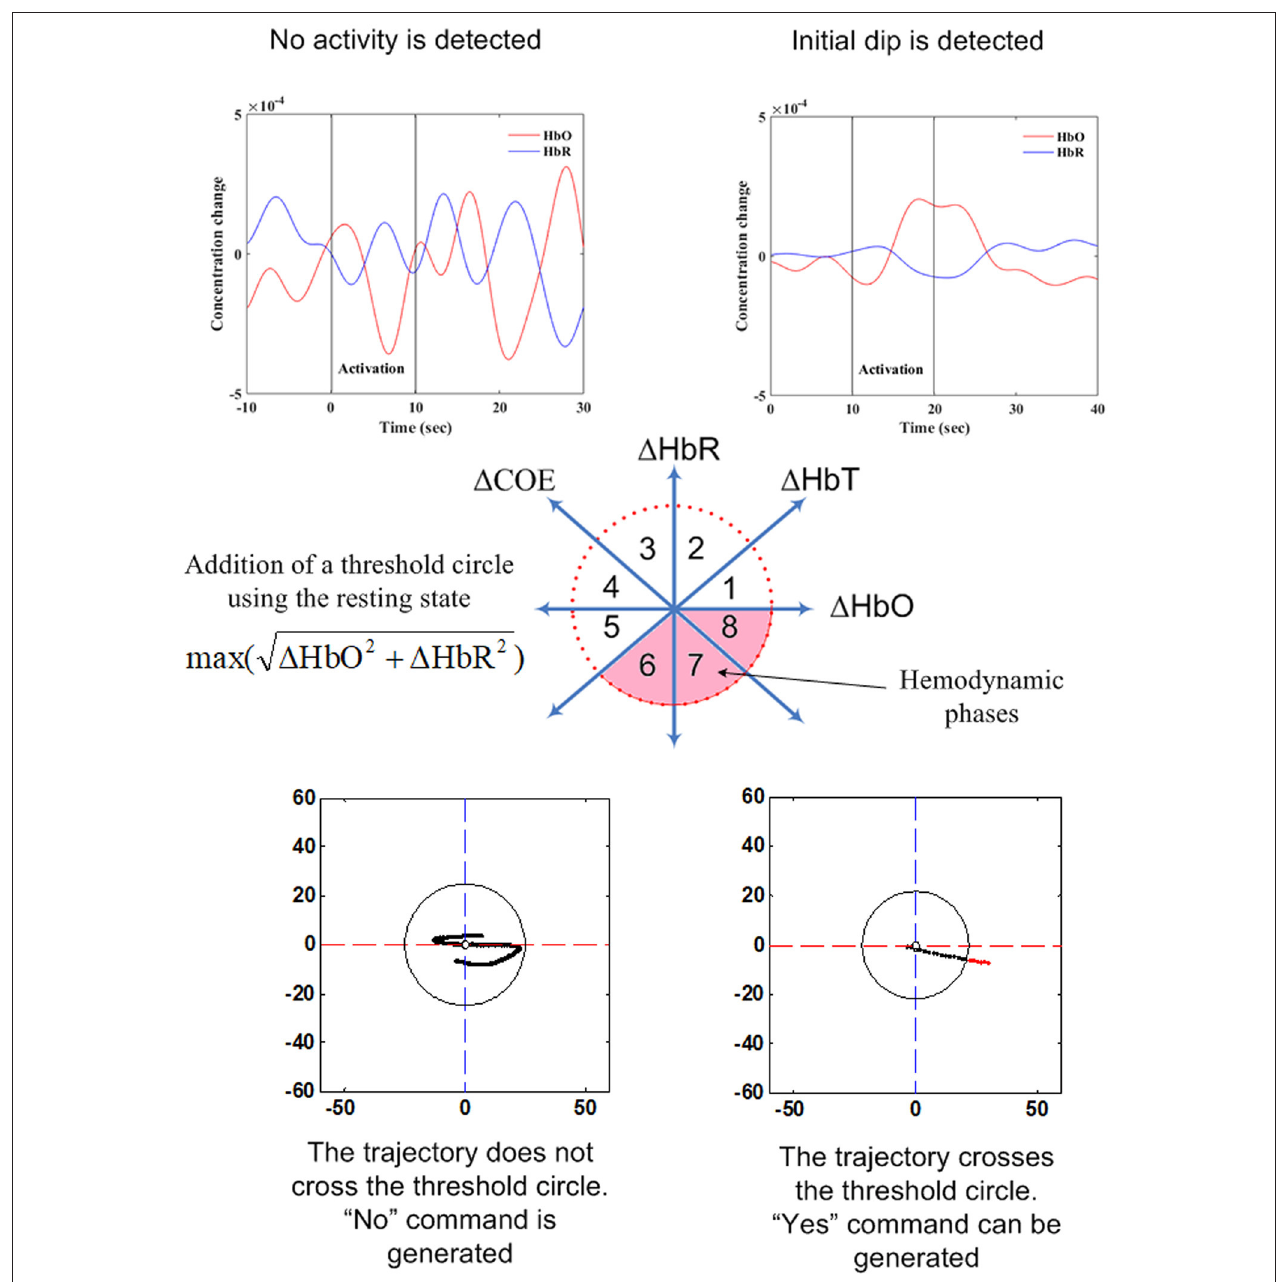
FIGURE 7 | Illustration of vector-phase analysis for two choice